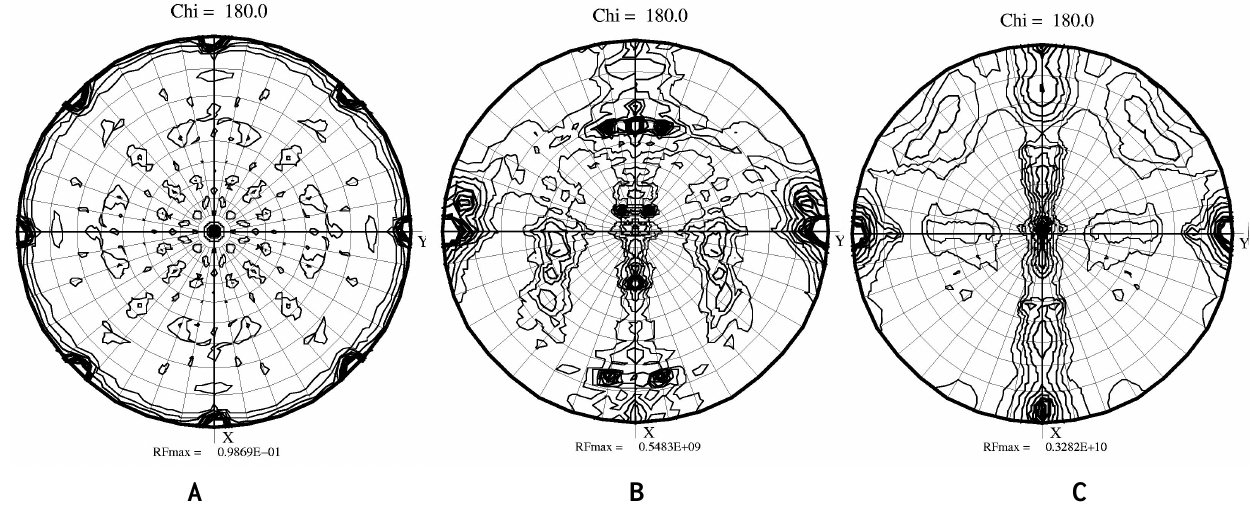
Figure 3. Plot of self-rotation function for all crystal forms of RUBISCO: (A) crystal form 1, (B) crystal form 2a, (C) crystal form 2b. Please note the presence of dominant features coinciding with crystallographic axes in the highly symmetric I422 crystal form, and the presence of multiple off-axis symmetry elements in lower symmetry P2 form. The peaks indicate the change of the direction of the a axis in different forms and suggesting the alignment of hexadecamers in form